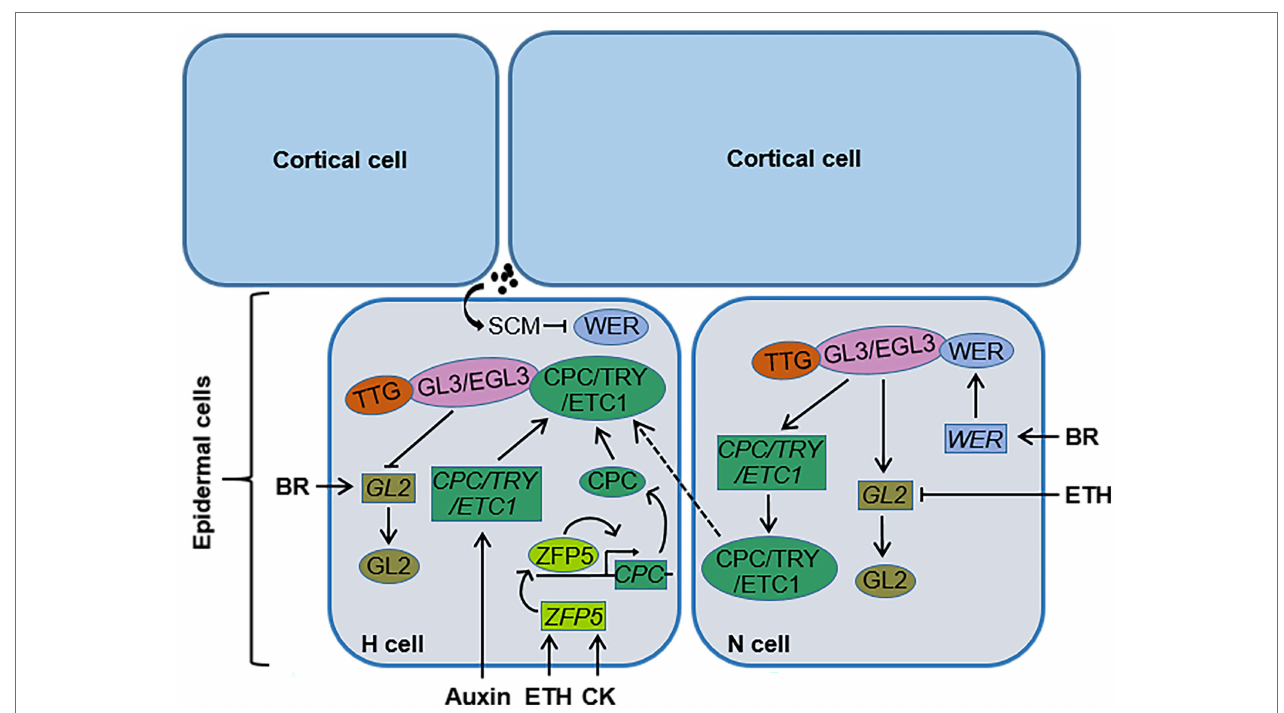
FIGURE 1 | The regulation pattern of phytohormones on root hair cell fate determination in Arabidopsis . In N-type cells, WEREWOLF (WER), GLABRA3 (GL3), ENHANCER OF GLABRA3 (EGL3), and TRANSPARENT TESTA GLABRA (TTG) form a transcription complex WER-GL3/EGL3-TTG, which can induce the expression of GLABRA2 ( GL2 ) and CAPRICE ( CPC ) in N-type cells. GL2 determines the differentiation of N-type cells, and CPC can move laterally from N-type cells to neighboring H-type cells. BR is able to upregulate the expression of WER . In H-type cells, SCRAMBLED (SCM) can be specifically activated by indeterminate signals from the junction of two cortical cells, and this activated SCM can inhibit the accumulation of WER. CPC competes with WER to bind the complex GL3/ EGL3-TTG. CPC and its functionally redundant homologs TRIPTYCHON (TRY) and ENHANCER OF TRY AND CPCs (ETC1) inhibit the expression of GL2 , which regulates the differentiation of H-type cells. Cytokinin (CK) and ethylene (ETH) promote CPC transcription through transcription factor ZINC FINGER PROTEIN 5 (ZFP5), auxin upregulates the expression of CPC , TRY , and ETC1 , and BR promotes the expression of GL2 in H-type cells. ETH inhibits the transcription of GL2 in N-type cells. → , positive regulation; ┤ , negative regulation; → , transmembrane transport; ·, unknown signal. N cell, N-type cell; H cell, H-type cell; SCM, SCRAMBLED; BR, brassinosteroid; ETH, ethylene; CK,